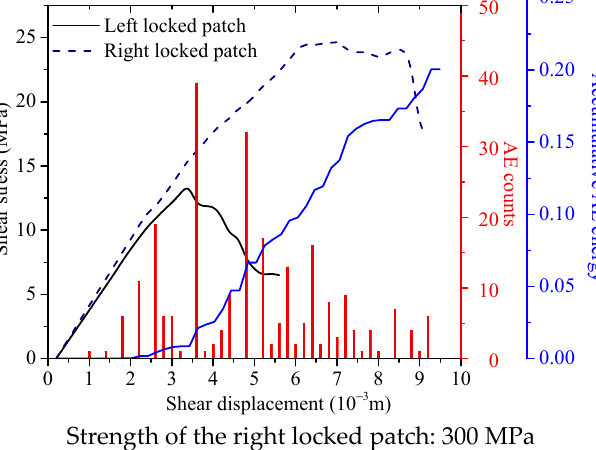
Figure 4. Effect of strength on the relationships between shear displacement and shear stress, AE counts, and AE accumulative energy.